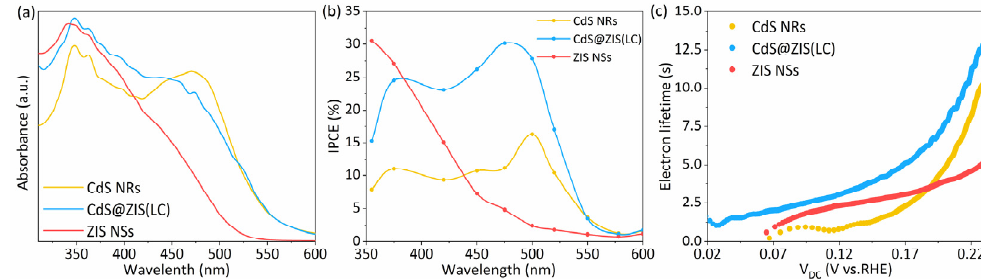
Figure 5. ( a ) UV—vis diffusive reflectance spectra and ( b ) IPCE spectra of CdS NRs, ZIS NSs (LC) and CdS@ZIS (LC). ( c ) The photoelectron lifetime under different potential.